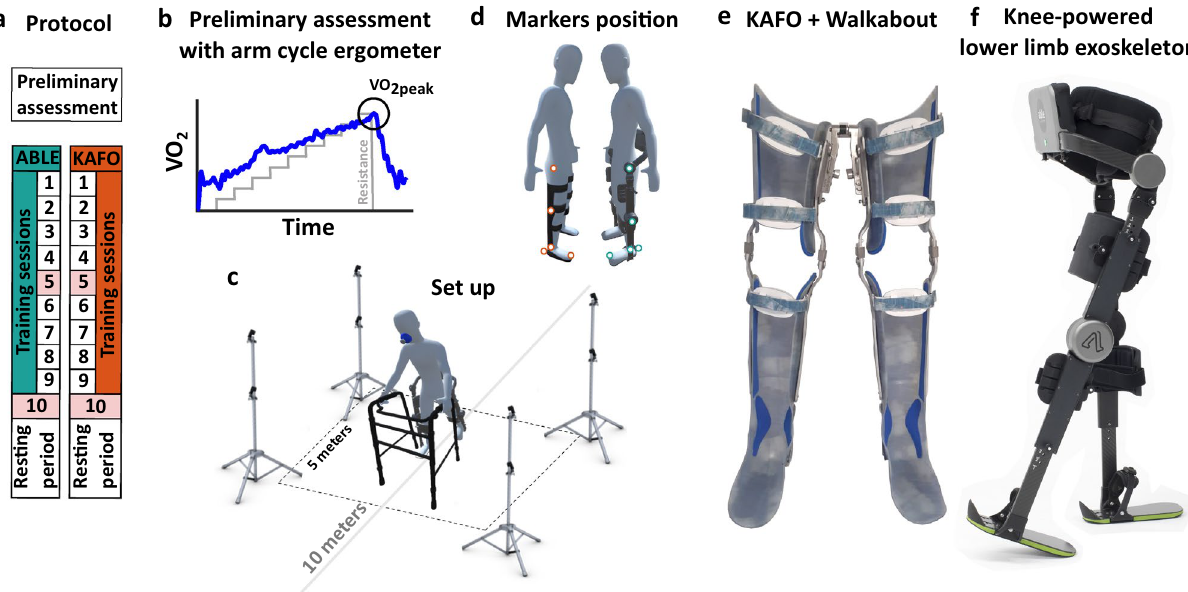
Figure 1. ( a ) Study protocol. ( b ) Representation of the data obtained from the GXT performed with an arm cycle ergometer. ( c ) Set up representation for the 6 MWT. ( d ) Marker protocol: Markers were placed at the trochanter, lateral side of the knee, lateral side of the ankle, hallux, and heel (achilles attachment). ( e ) Knee- ankle-foot orthoses with Walkabout. ( f ) Knee-powered lower limb exoskeleton; i.e., the ABLE Exoskeleton (ABLE Human Motion S.L., Barcelona,